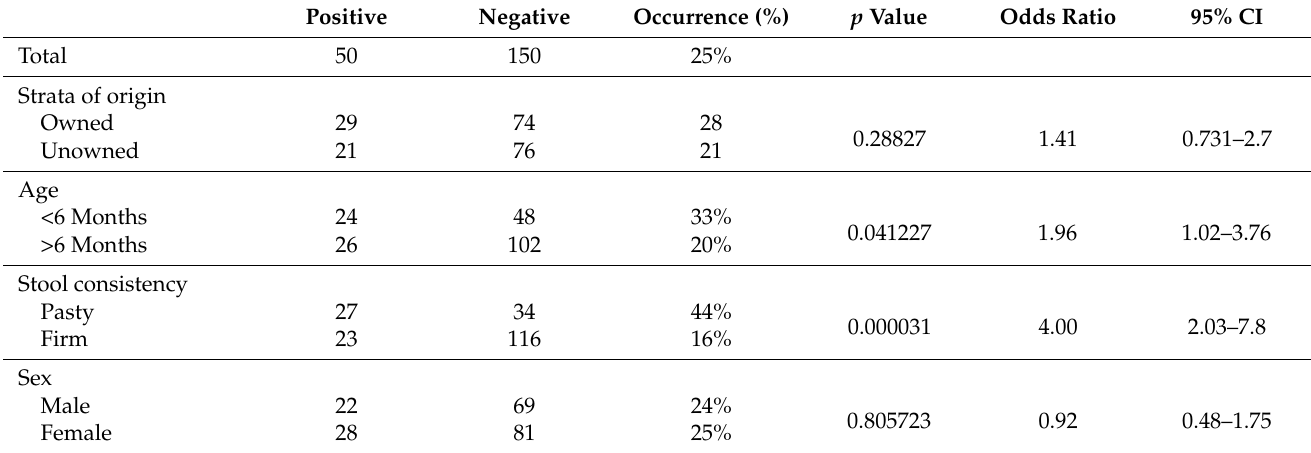
Table 2. Distribution of samples and statistical association analysis by stratum, age, stool consistency, and